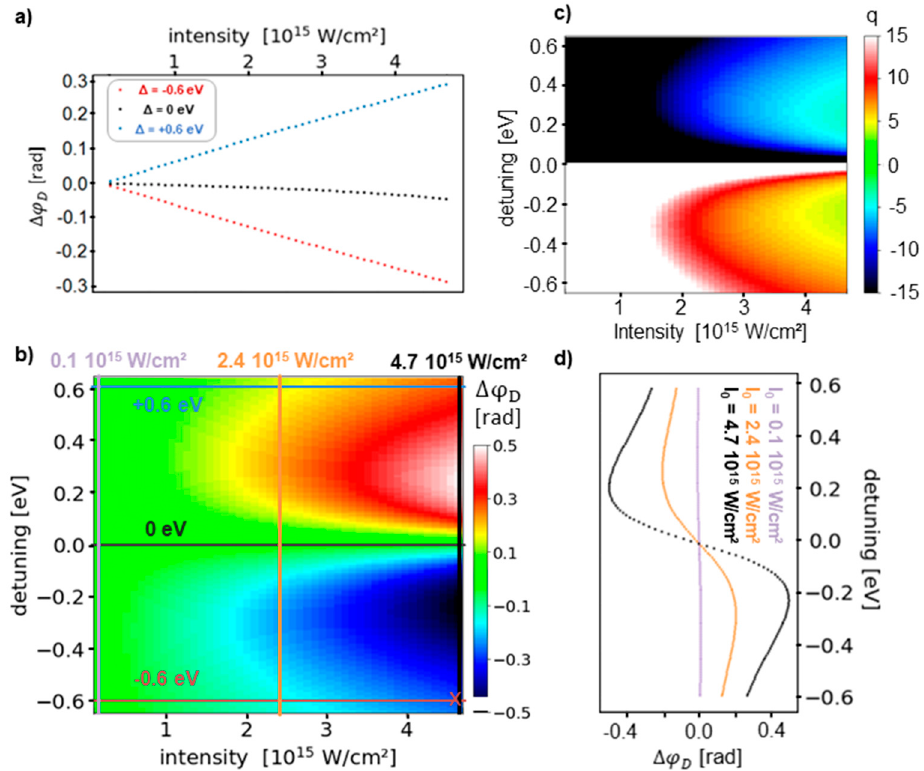
Figure 2. Results for the two-level system obtained by fitting a generalized Fano line shape (Equation (4)) to the simulated optical density. ( b ) dipole phase shift ∆ ϕ D obtained after applying Equation (5) to the direct fit results of q shown in ( c ) as a function of detuning and intensity, with corresponding ( a ) horizontal lineouts as a function of intensity for di ff erent detunings and ( d ) vertical lineouts as a function of detuning for di ff erent intensities. ( c ) the fitted q -parameter as a function of detuning and intensity.